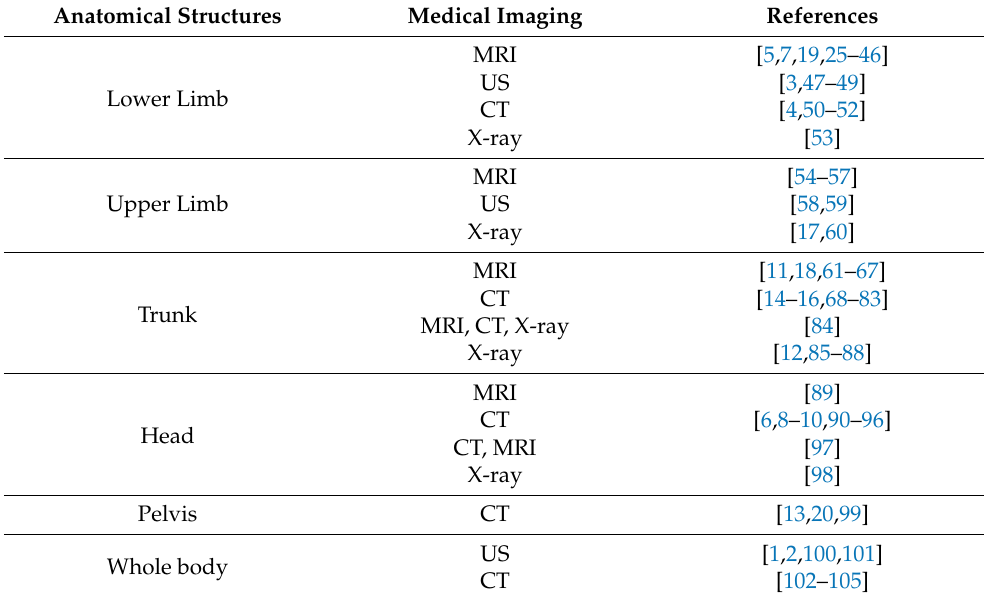
Table 1. Musculoskeletal anatomical structures and related bioimaging techniques investigated with deep learning approaches for object